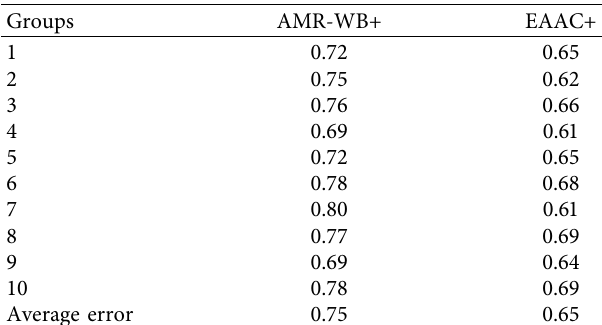
Table 4: 10 Groups of handwriting information average error test